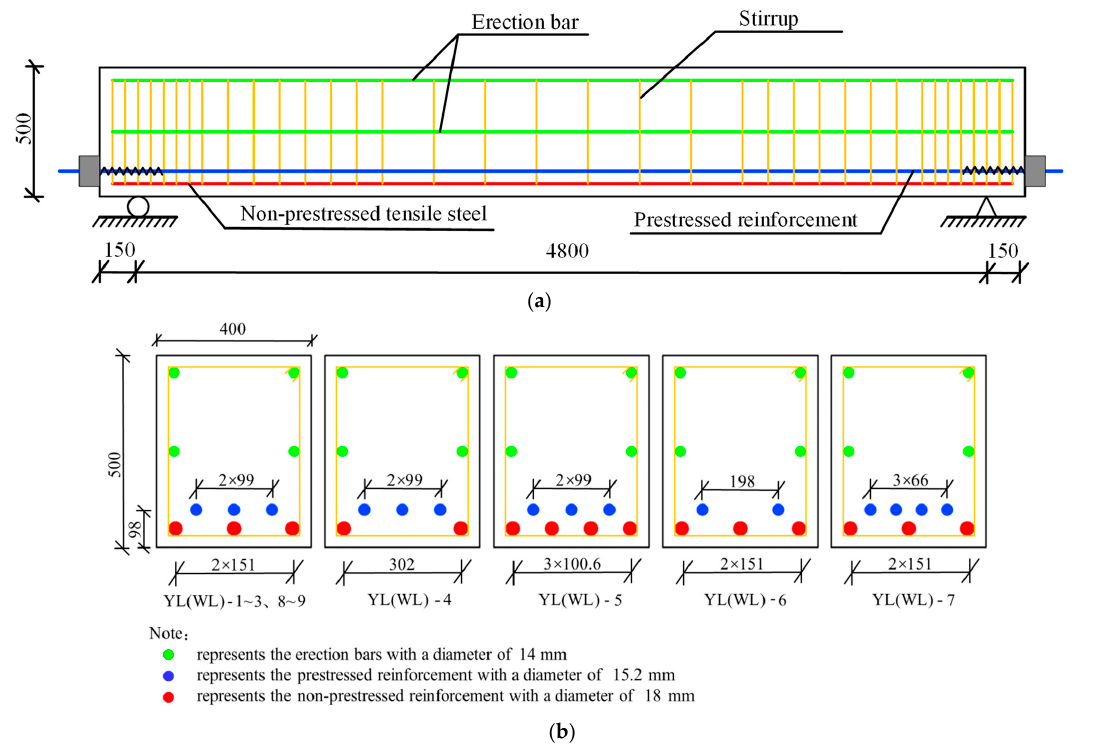
Figure 1. Dimensions and reinforcement layout of the test beams (Unit: mm): ( a ) dimensions of the test beams; ( b ) reinforcement layout of the test beams. The design differences of each beam are shown in Table 1. Table 1. Design parameters of each test beam.